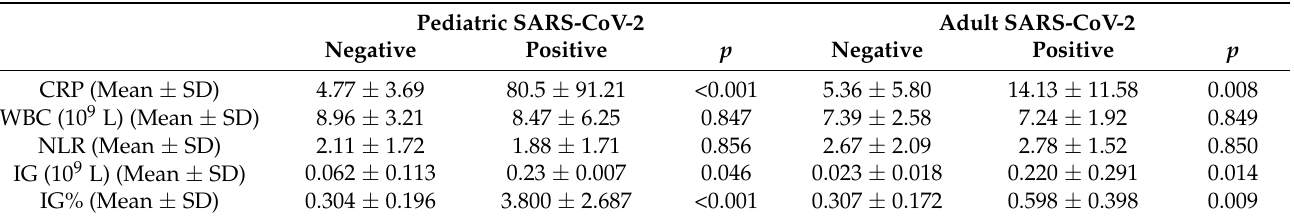
Table 2. Comparison of laboratory data in pediatric and adult patients according to the presence of SARS-CoV-2. Pediatric